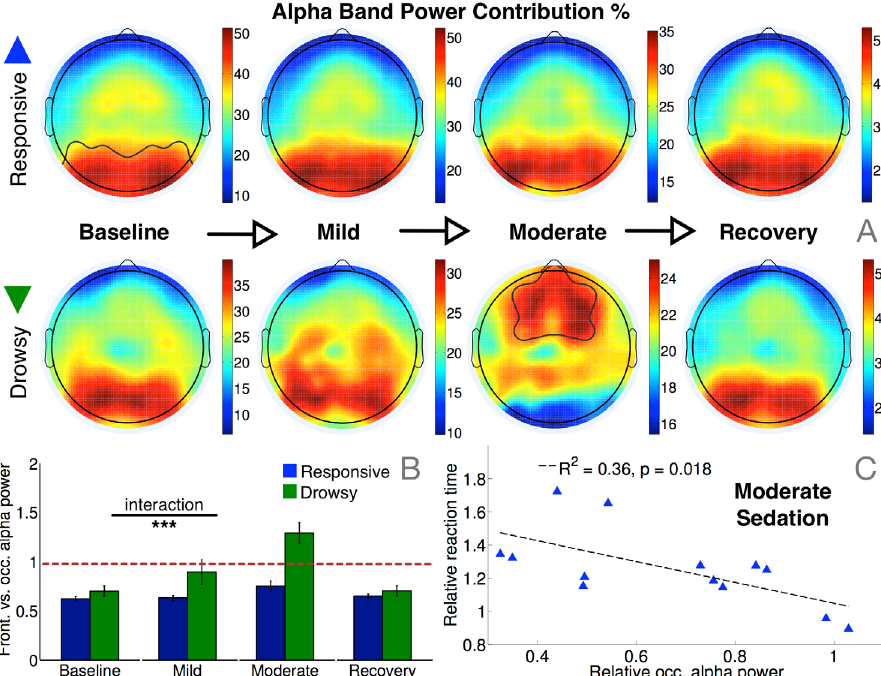
Fig 5. Alpha band power changes as a function of sedation. (A) Alpha power topography in the drowsy group progressively switched from an occipital to a frontal pattern during moderate sedation, while the responsive group remained stable throughout. (B) The resulting interaction between group and level of sedation on their alpha power contributions from frontal vs. occipital channels was statistically significant (F (3) = 10.1, p = 0.0008). (C) Even amongst the responsive group, reduction in relative occipital alpha power during moderate sedation was correlated with relatively slower reaction time, relative to